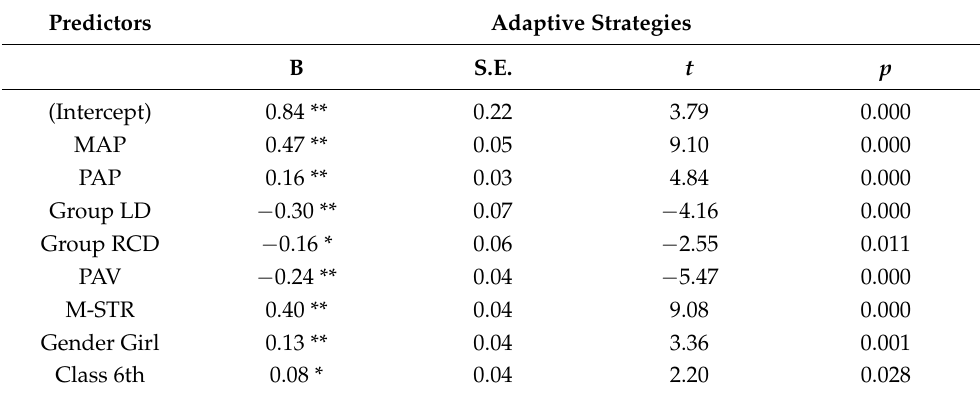
Table 5. Model 2: Linear regression analysis for predicting adaptive strategies.